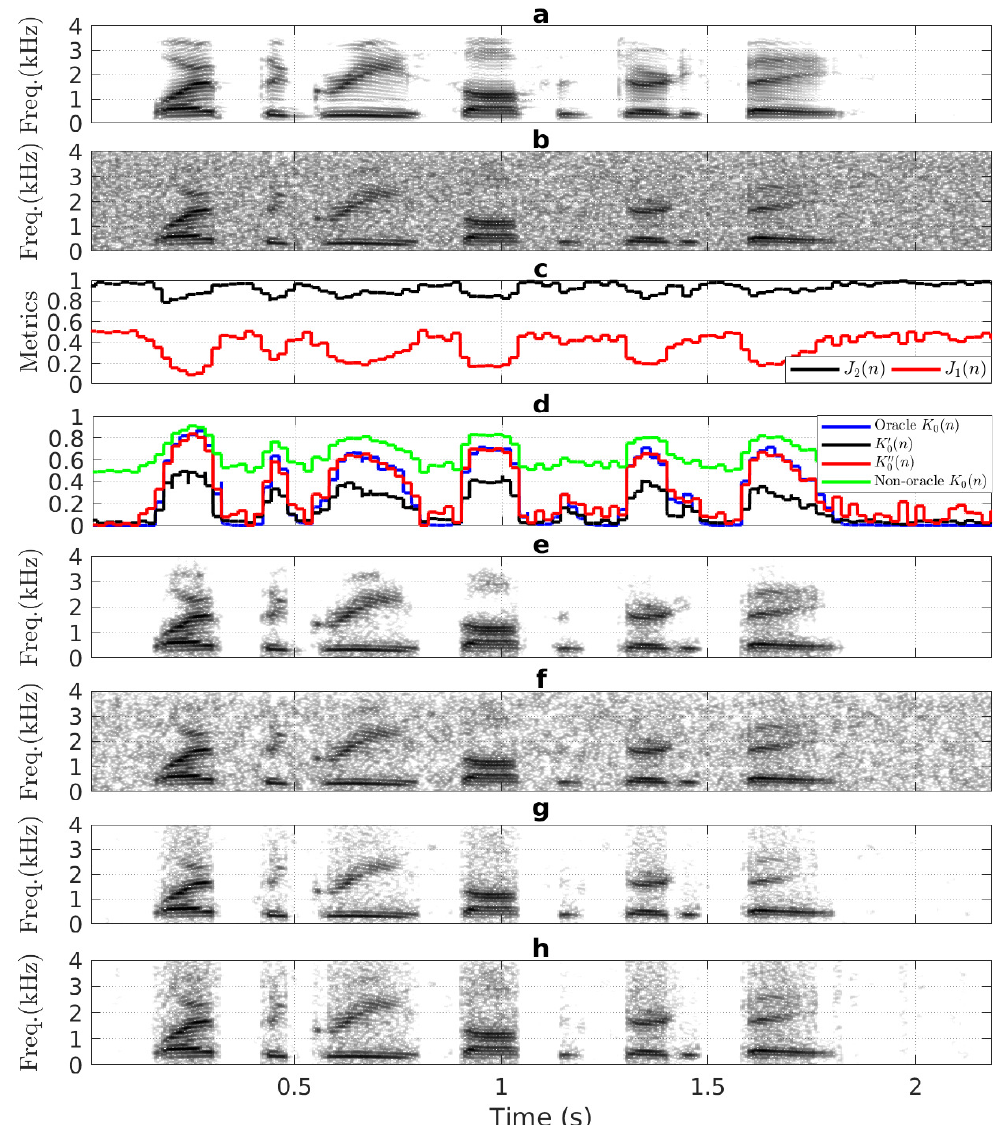
Figure 1. Review of existing KF-based SEA: ( a , b ) spectrograms of the clean speech (utterance sp05) and the noisy speech (corrupt ( a ) with 5 dB WGN), ( c ) J 2 ( n ) and J 1 ( n ) metrics, ( d ) oracle and ( n ) and K (cid:48)(cid:48) ( n ) , spectrogram of enhanced speech produced by: non-oracle K 0 ( n ) with adjusted K (cid:48) 0 0 ( e ) KF-oracle method, ( f ) KF-non-oracle method, ( g , h ) methods in